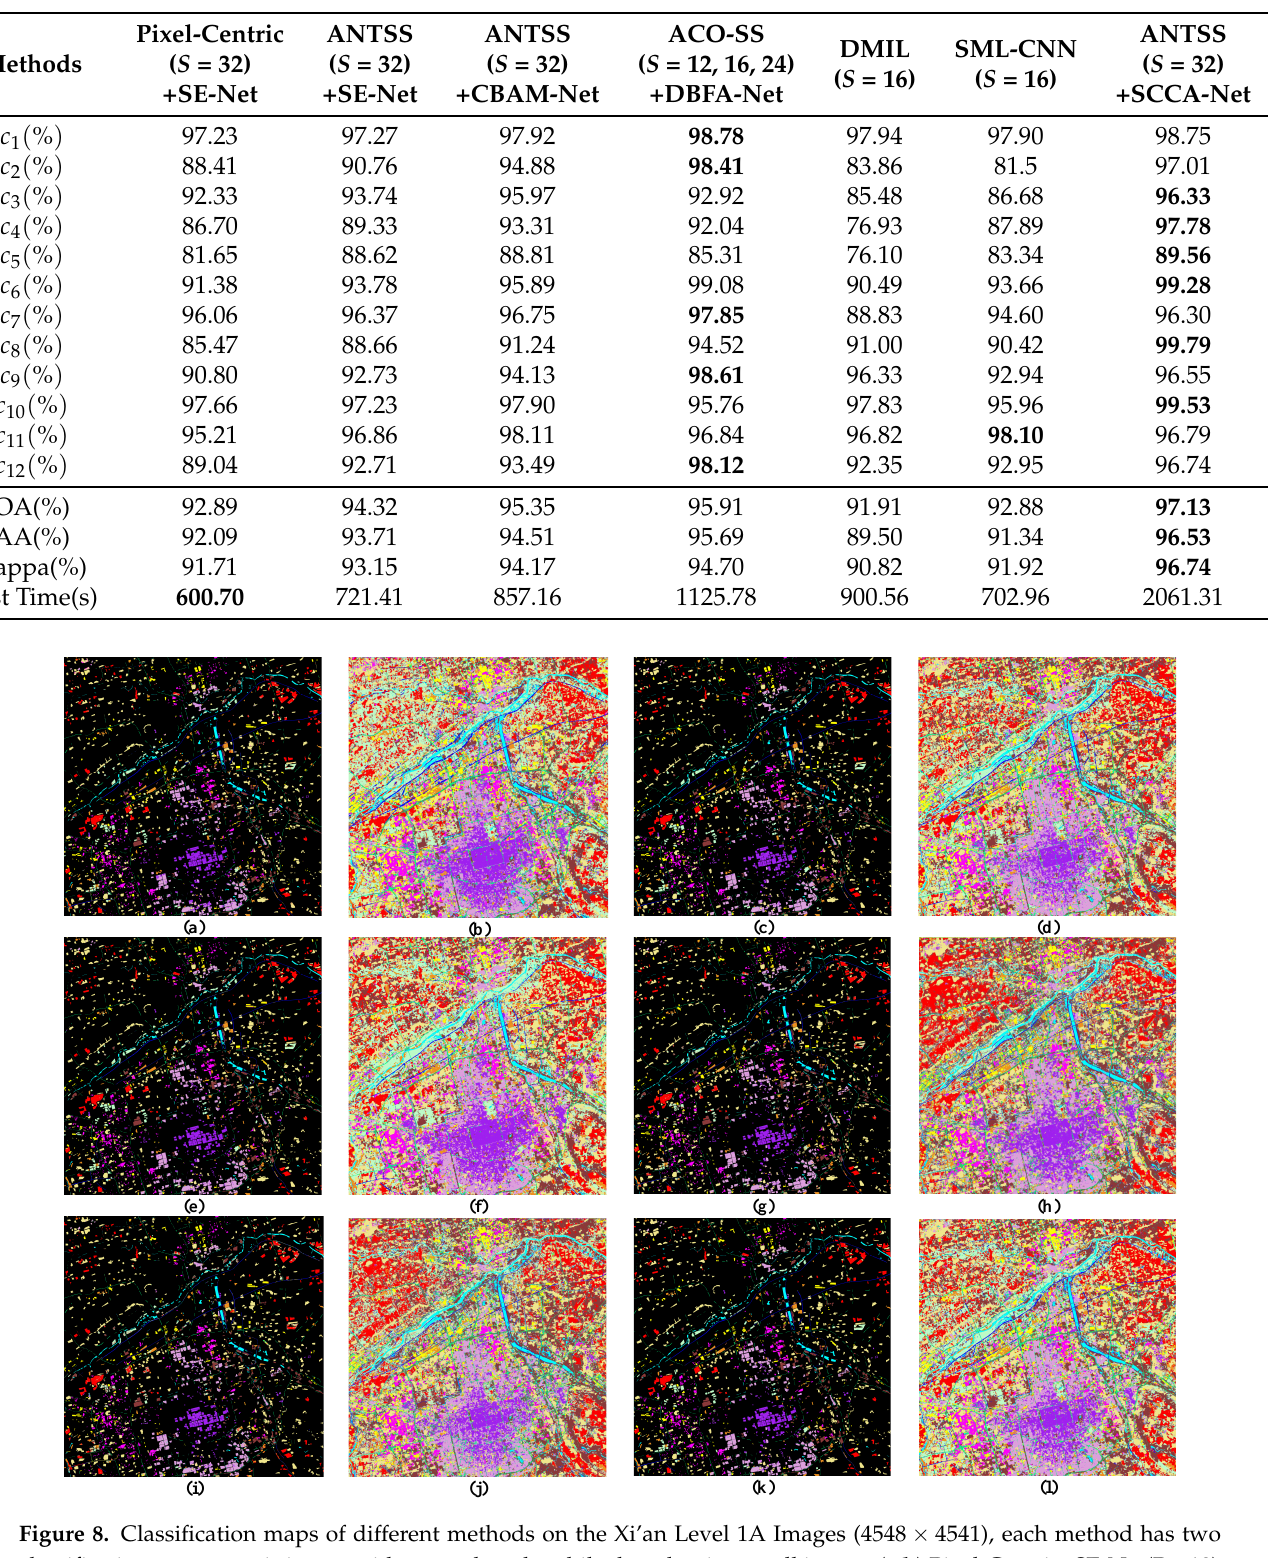
Table 4. Quantitative Classification Results of Xi’an Level 1A Images.